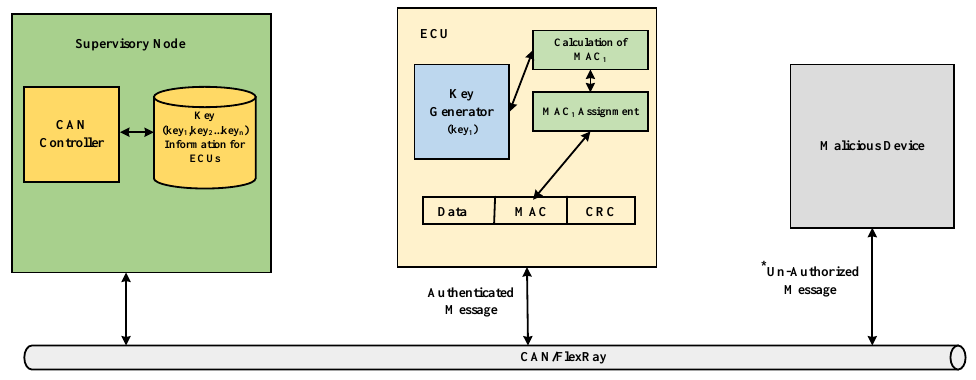
Figure 12. Centralized framework consisting of Supervisory Node [92].